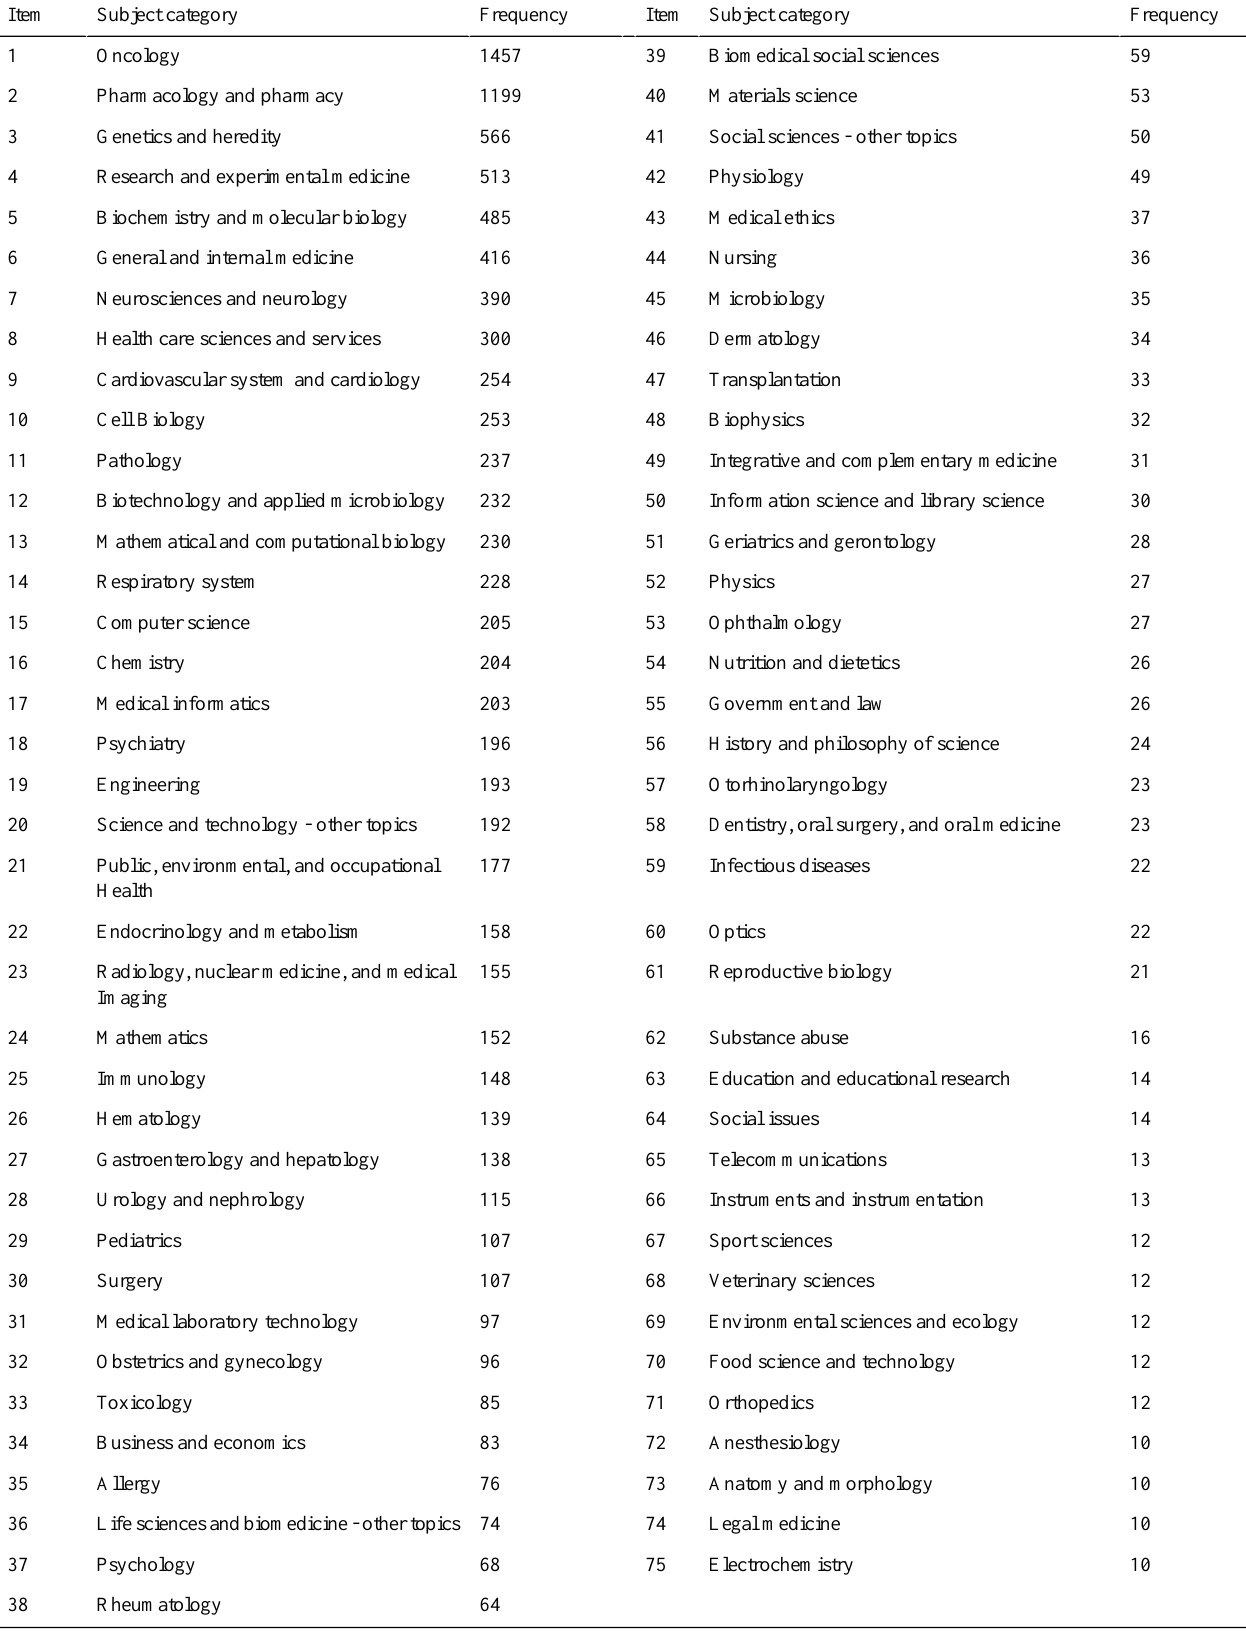
Table 1. Seventy-five disciplines with frequencies equal to or greater than 10 involved in precision medicine